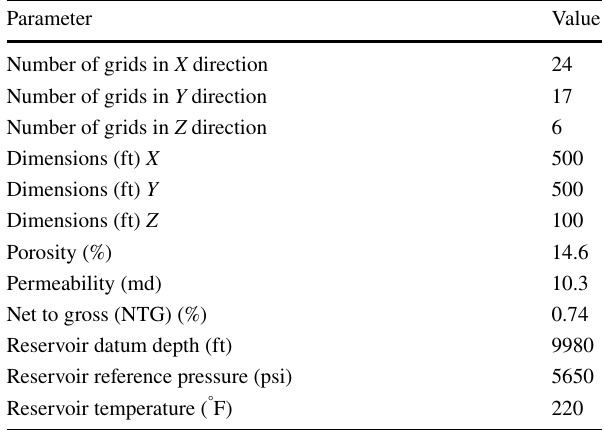
Table 3 General properties of the reservoir Parameter Value Number of grids in X